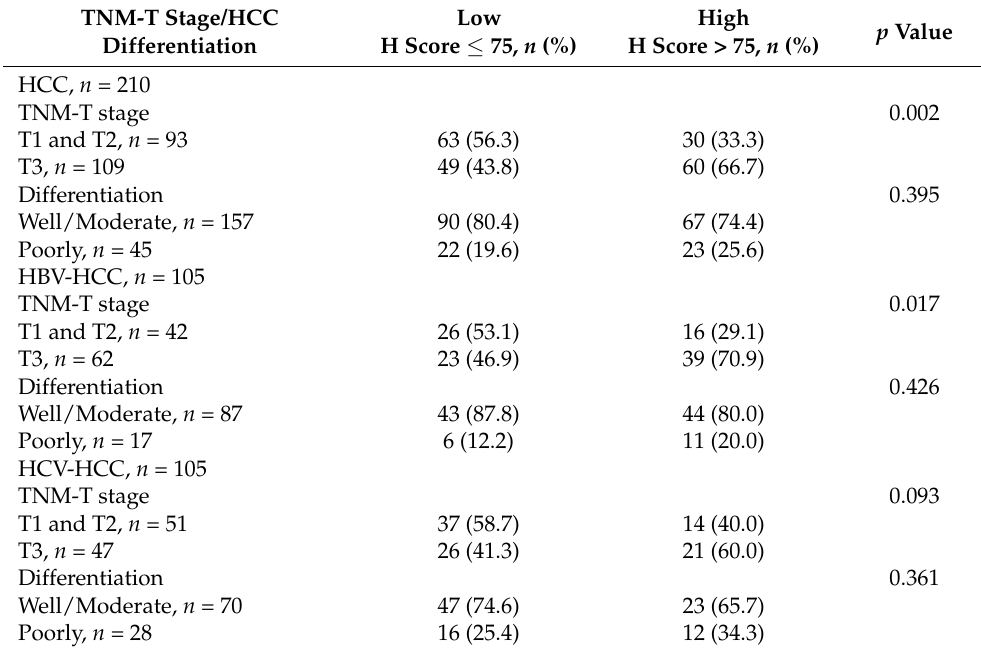
Table 3. Tid1 expression in non-tumor part of liver tissues.